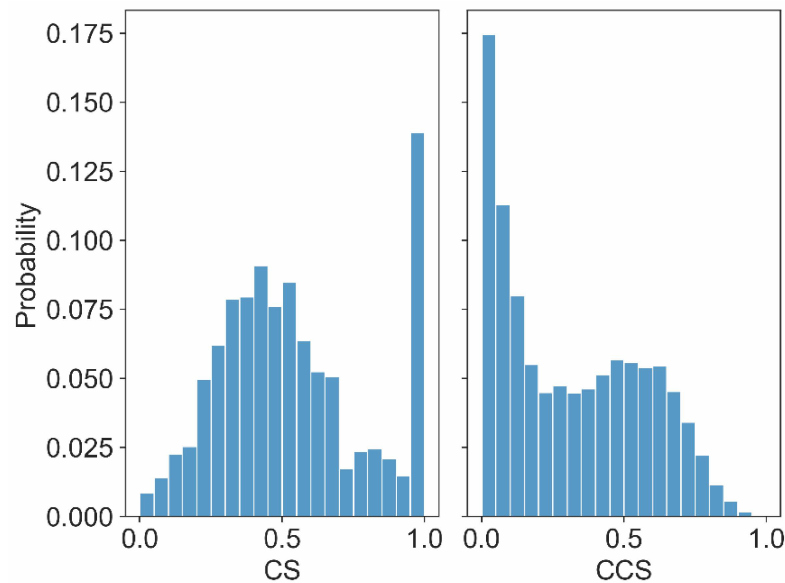
Figure 2. The distribution of the residue conservation scores in the spike